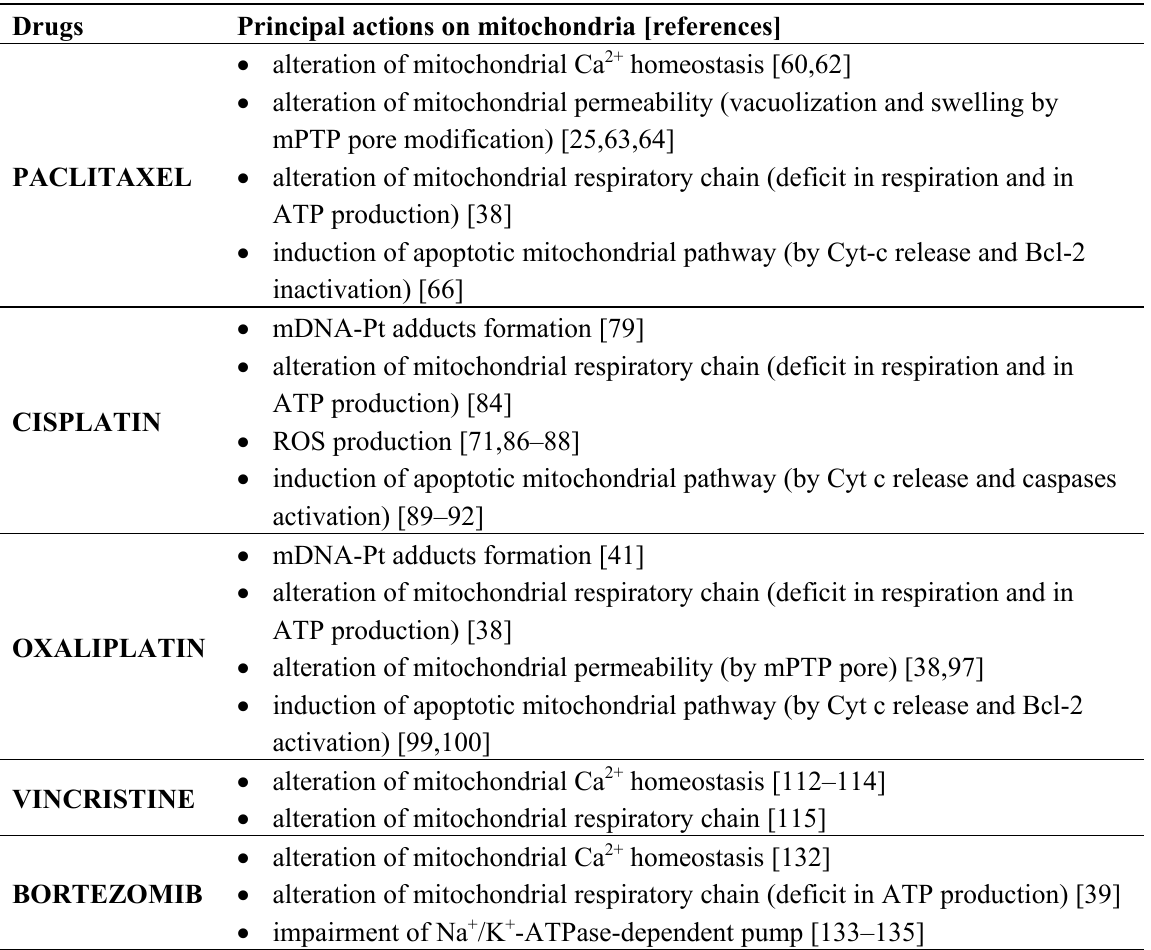
Table 2. Summary of some of the principal effects of chemotherapeutic drugs on mitochondria in the peripheral nervous